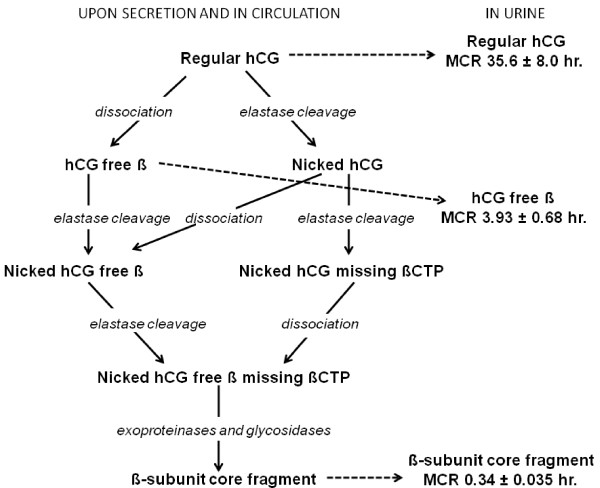
The dissociation, degradation and clearance pathways of regular hCG [39,78-87]. Metabolic clearance half-times (MCR) are those published by Wehman and colleagues [85-88]. Similar degradation and clearance pathways are predicted for hyperglycosylated hCG and hyperglycosylated hCG free β with an end product of urine β-subunit core fragment.